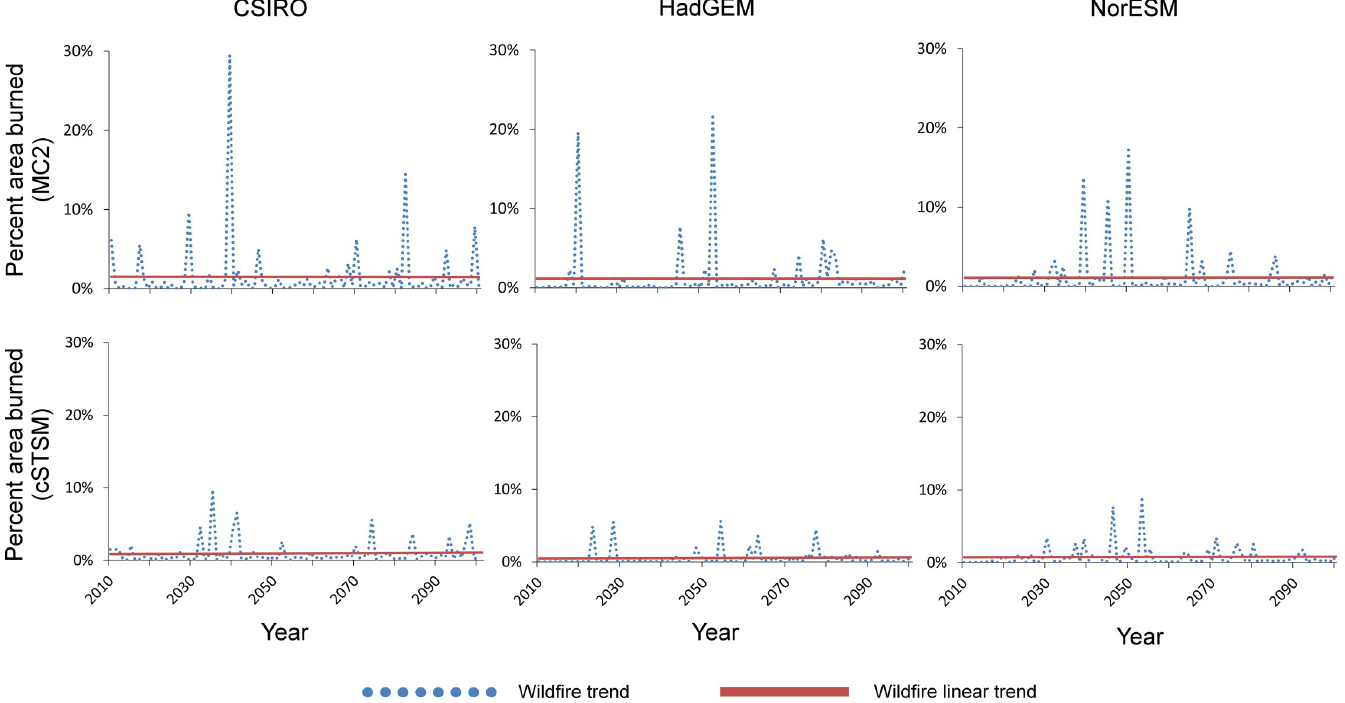
Fig 3. Projected wildfire trends by MC2 and a randomly selected cSTSM simulation iteration. Differences in wildfire projections between MC2 and cSTSMs largely reflect distinct model assumptions about wildfire. Specifically, MC2 is deterministic in setting burn probabilities/events, whereas the stochastic nature of cSTSMs results in fewer wildfire opportunities (even with a slightly increasing trend in area burned with time under changing